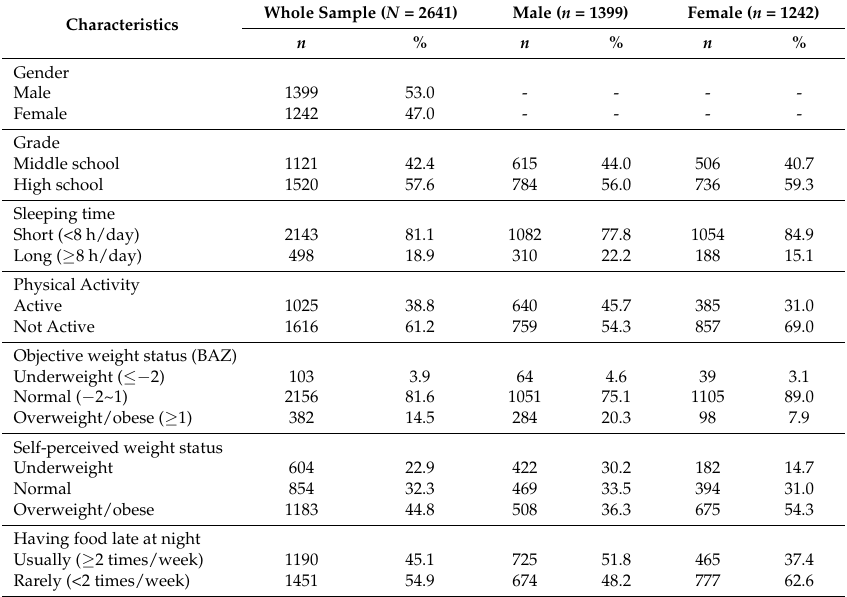
Table 1. Characteristics of the study population ( N =